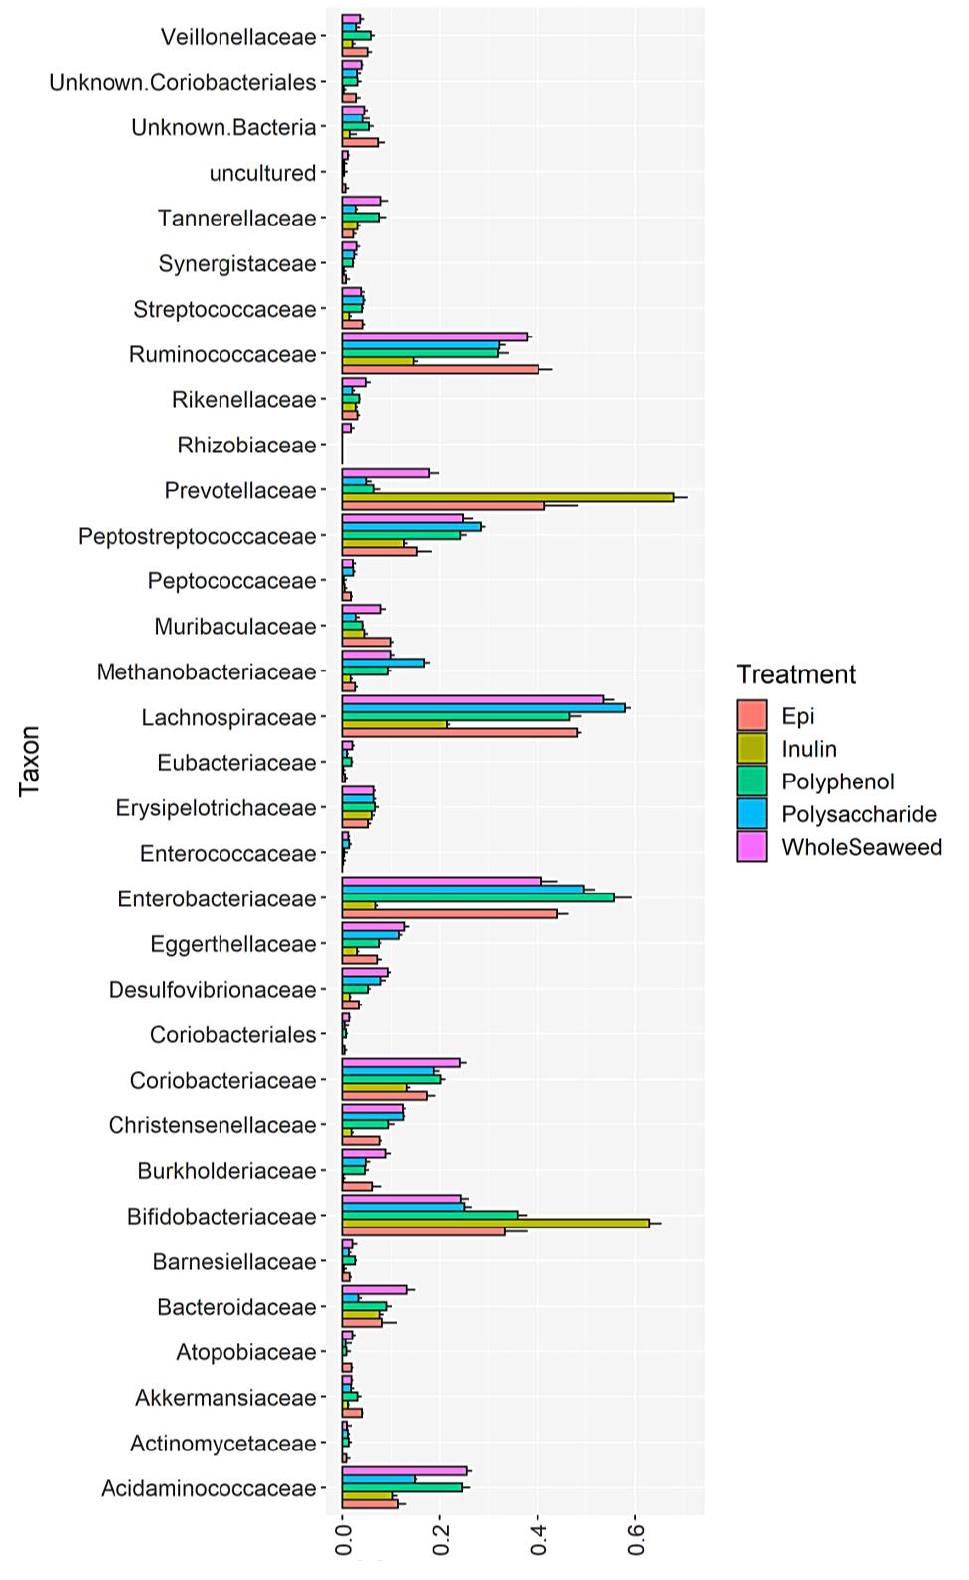
Figure 3. Relative abundance of bacterial families after 24 h fermentation with U. ohnoi WH, PS, PP, INU or EGCG.